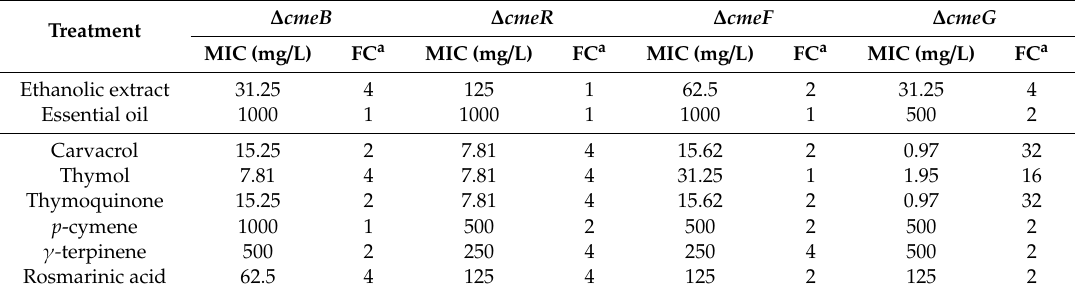
Table 3. Antimicrobial activity of Satureja montana ethanolic extract and essential oil, and of the six pure compounds against the Campylobacter jejuni 11,168 e ffl ux pump mutants, in terms of their minimal inhibitory concentrations (MICs). ∆ cmeB , lacking functional e ffl ux pump CmeABC; ∆ cmeR , lacking repressor of e ffl ux pump CmeABC; ∆ cmeF , lacking functional e ffl ux pump CmeDEF; and ∆ cmeG , lacking functional e ffl ux pump